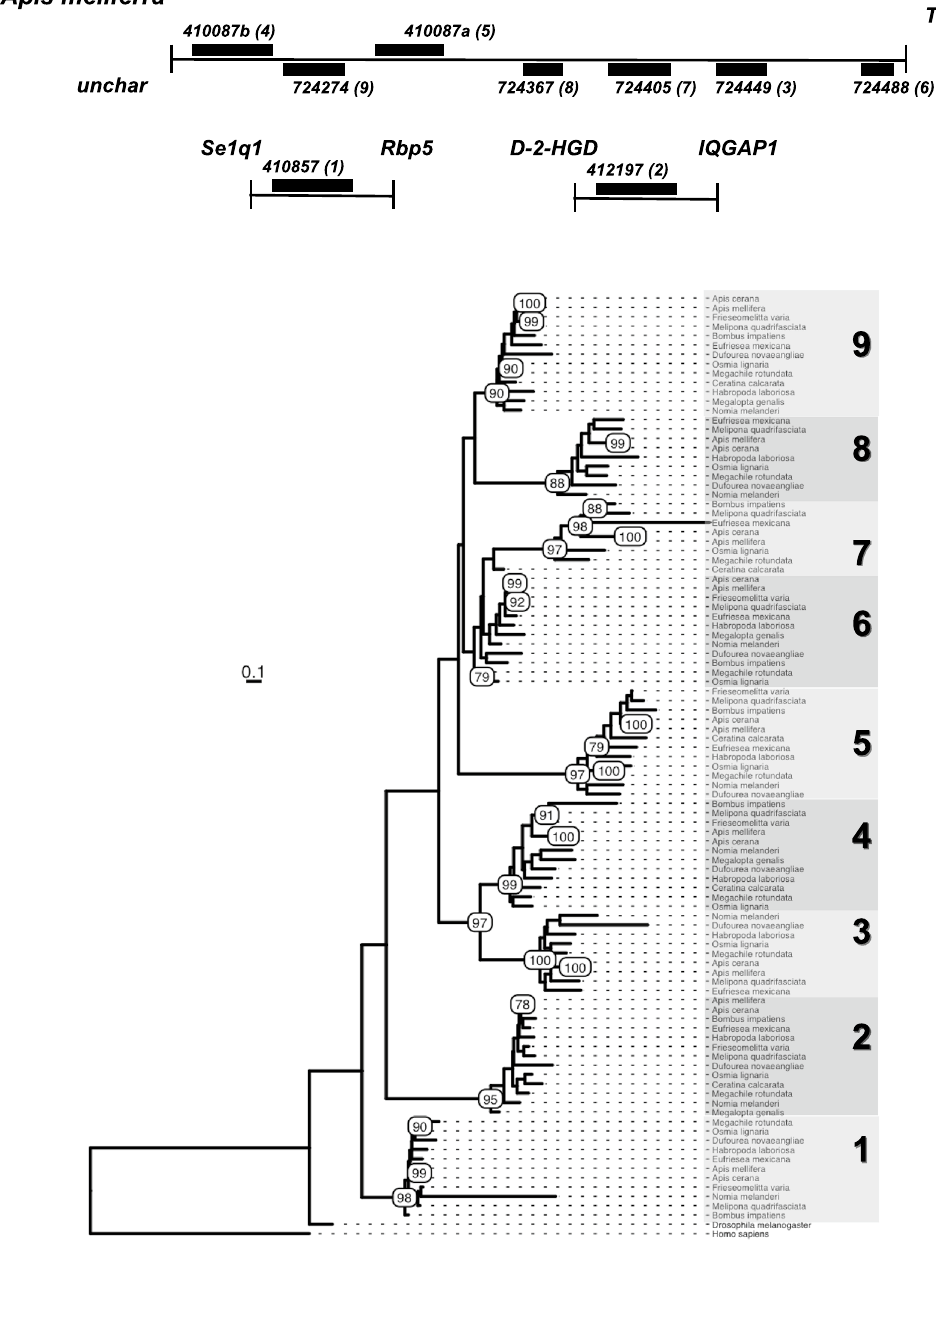
Figure 1. l(2)efl genes and proteins in bees. Schematic of the gene organization of l(2)efl genes in select bee species (both genes found in the cluster as well as genes found outside) ( A ). Phylogenetic tree of D. melanogaster l(2)efl proteins, bee l(2)efl proteins (see “Methods”), and H. sapiens alpha-crystallin B protein based on full amino acid sequences. Scale bar represents corresponds to the number of amino acid changes per site ( B